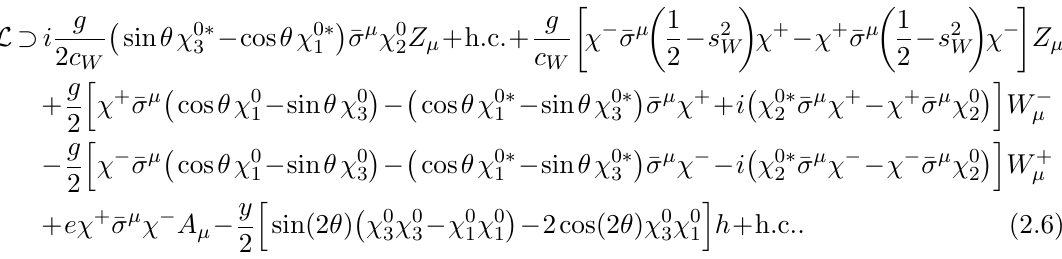
and (cid:31) 0 in the dark fermion model. 1 2 m 1 (left) for (cid:12)xed values of j j (cid:31) 0 (cid:31) 0 . 1 1 !